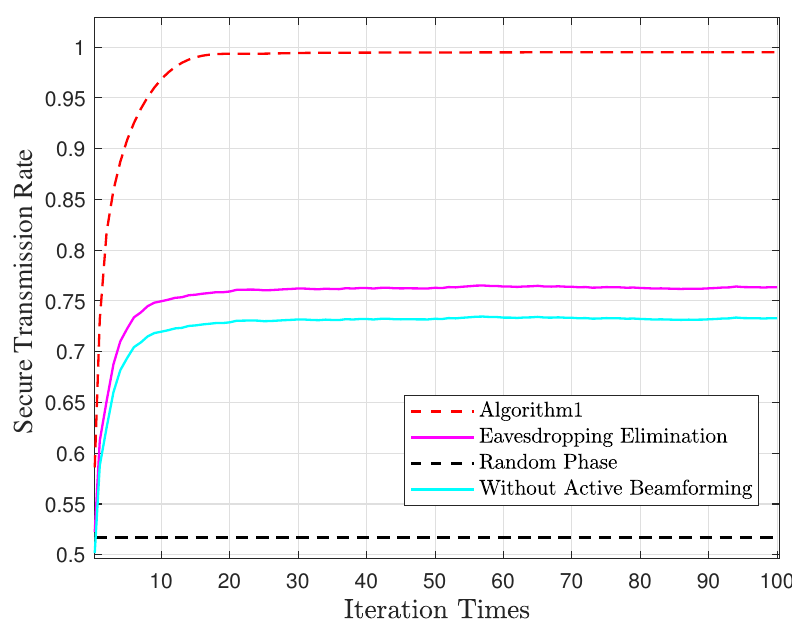
Figure 3. Maximum secure transmission rate with iteration times.